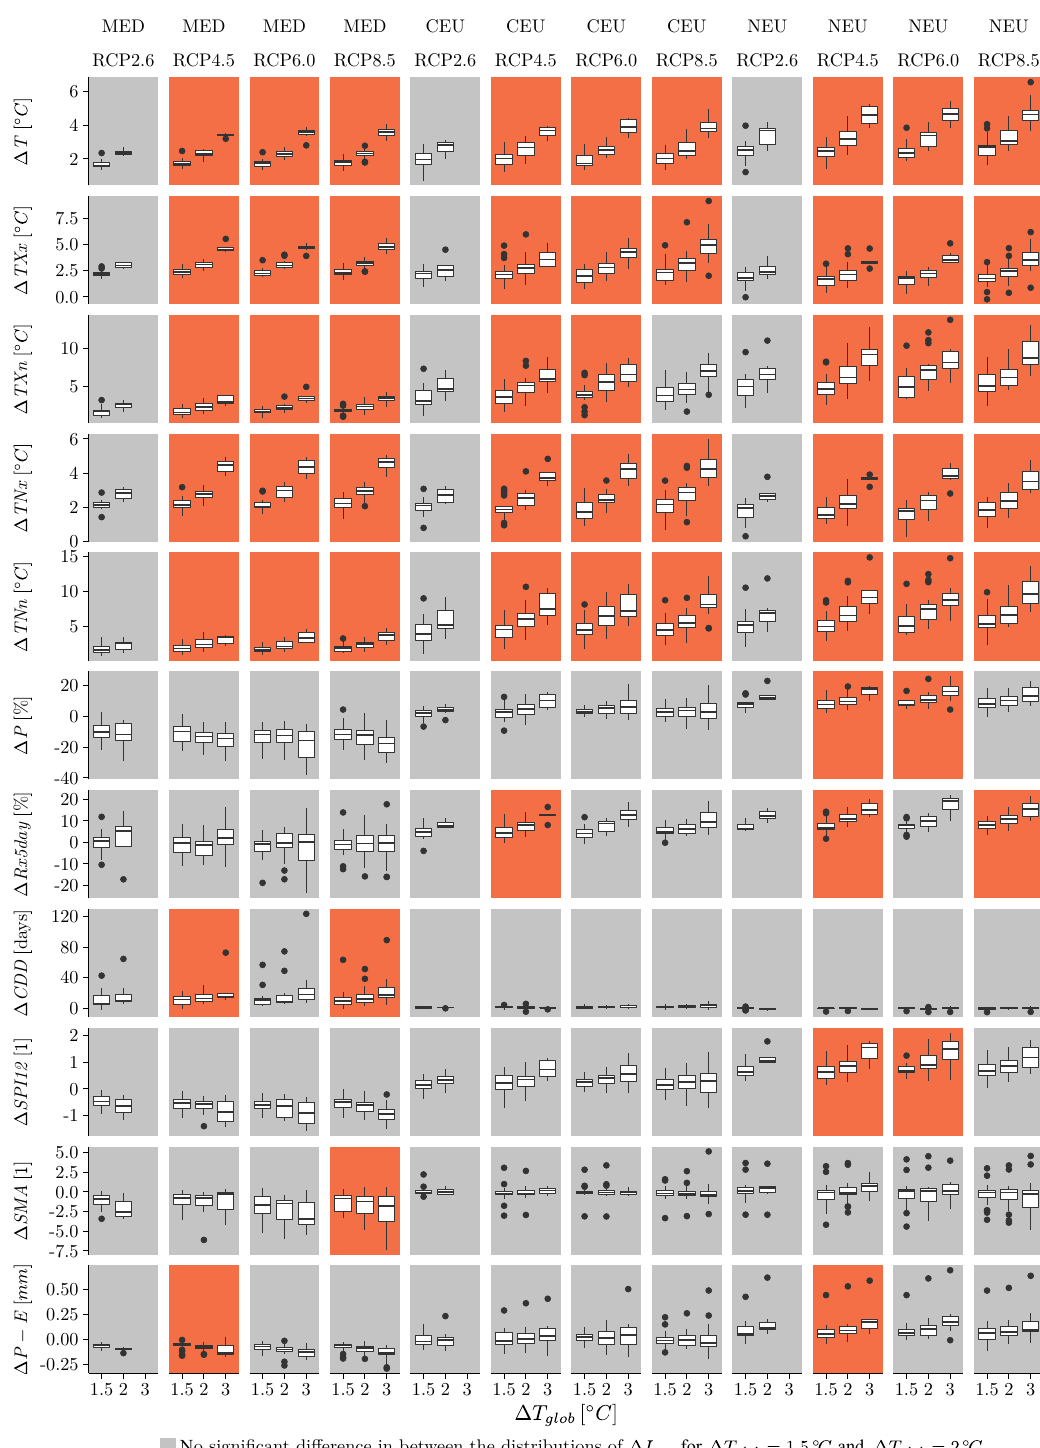
for and ignificant difference in between the distributions of for andS Figure 5. Response of indices (cid:49)T , (cid:49)T Xx , (cid:49)T Xn , (cid:49)T Nx , (cid:49)T Nn , (cid:49)P , (cid:49) Rx5day, (cid:49) CDD, (cid:49) SPI12, (cid:49) SMA, and (cid:49)P − E to a global mean temperature increase of 1 . 5, 2, and 3 ◦ C based on CMIP5 simulations of ensemble member r1i1p1 and averaged over the European SREX regions MED, CEU, and NEU. The upper and lower hinges of the box plots represent the first and third quartiles. The whiskers extend to the highest (lowest) value that is within 1.5 times the interquartile range of the upper (lower) hinge. The central line of each box plot indicates the median value. Values outside this range are displayed as